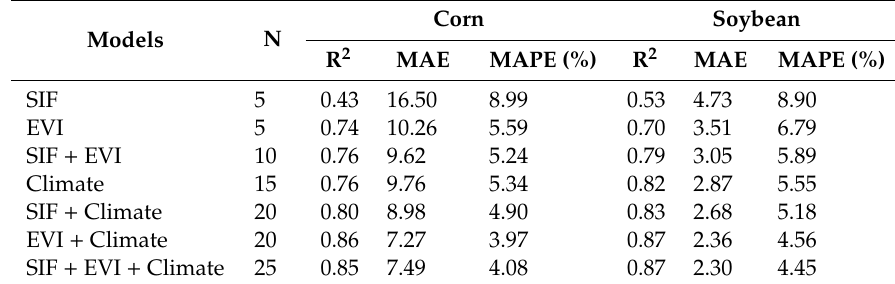
Table 1. Averaged performances of DNNs models for predicting county-level corn and soybean yields in the Midwestern 12 states. a